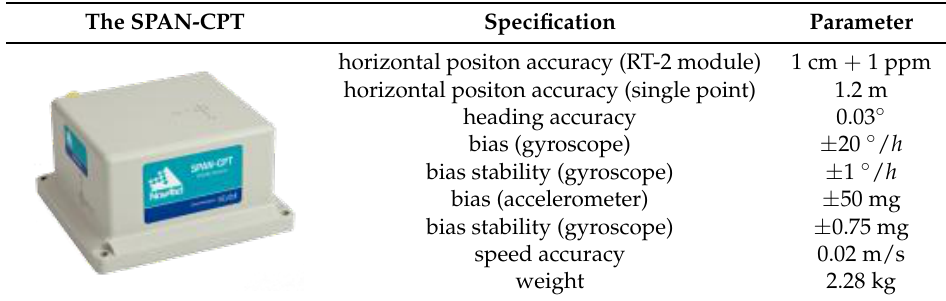
Table 8. The SPAN-CPT